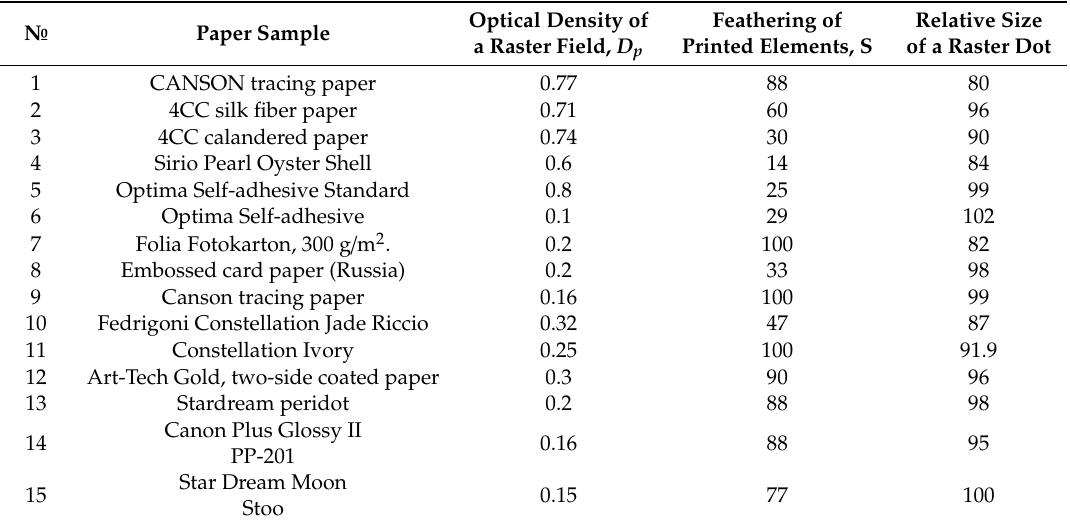
Table 1. The results of densitometry measurements.